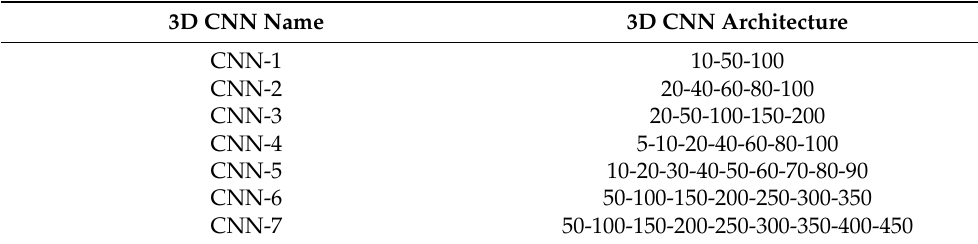
Table 1. The 3D CNNs architectures used. The numbers in the chart represent the number of kernels in a particular layer. The dashes stand for the following: batch normalization, RELu, and max-pooling layers. There is a fully connected layer at the end of each network with 10 hidden and 2 output